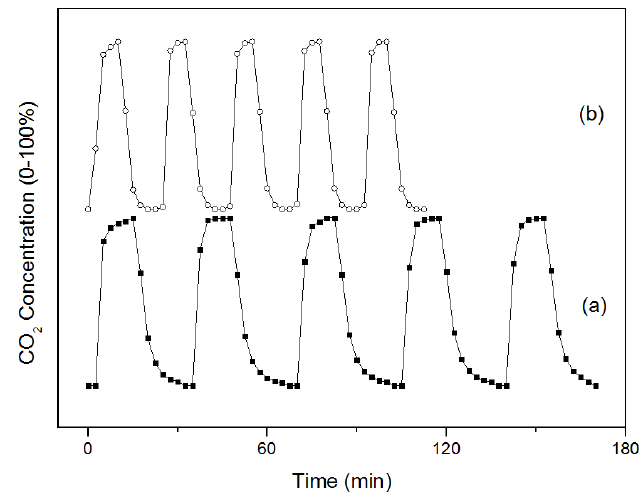
Figure 5. Five consecutive CO 2 adsorption/desorption cycles on (a) Na ‐ SSZ ‐ 13 ‐ micro ‐ 40 and (b) H ‐ SSZ ‐ 13 ‐ micro ‐ 40 materials.